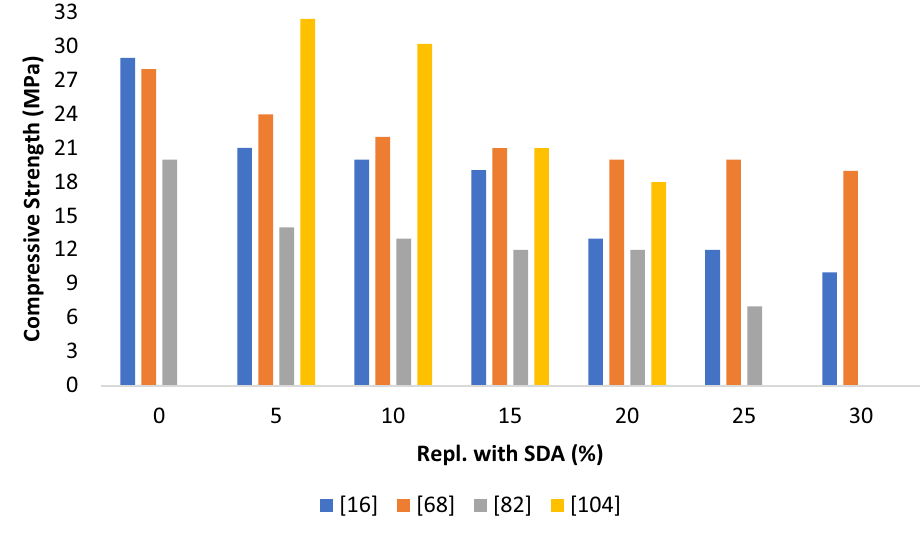
Fig. 7 Effects of varying SDA proportion on the compressive Strength properties [16, 68, 82,